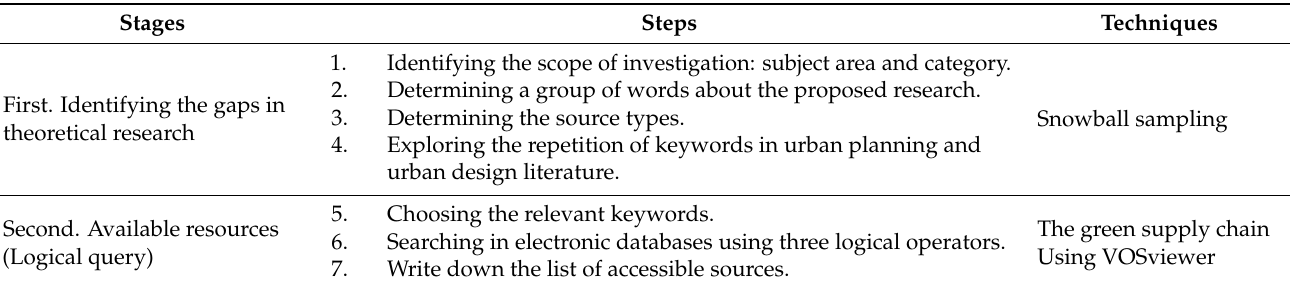
Table 4. The BSMS